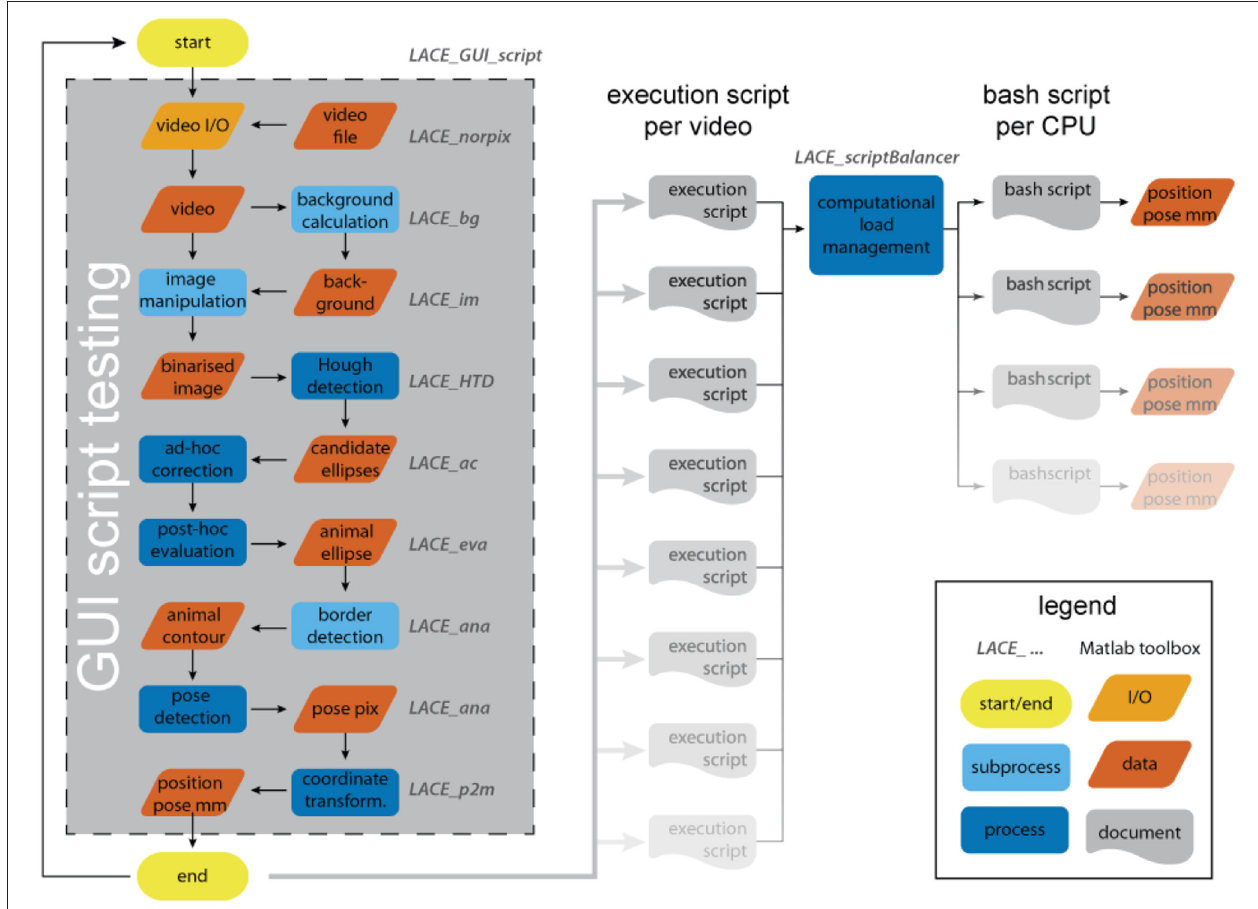
FIGURE 1 | The analysis flow of LACE. The user interacts with most toolboxes through a graphical user interface (GUI). The GUI results in an execution script that holds all information and file positions to run an analysis on the entire video. By testing the script inside the GUI, the system is able to calculate the analysis